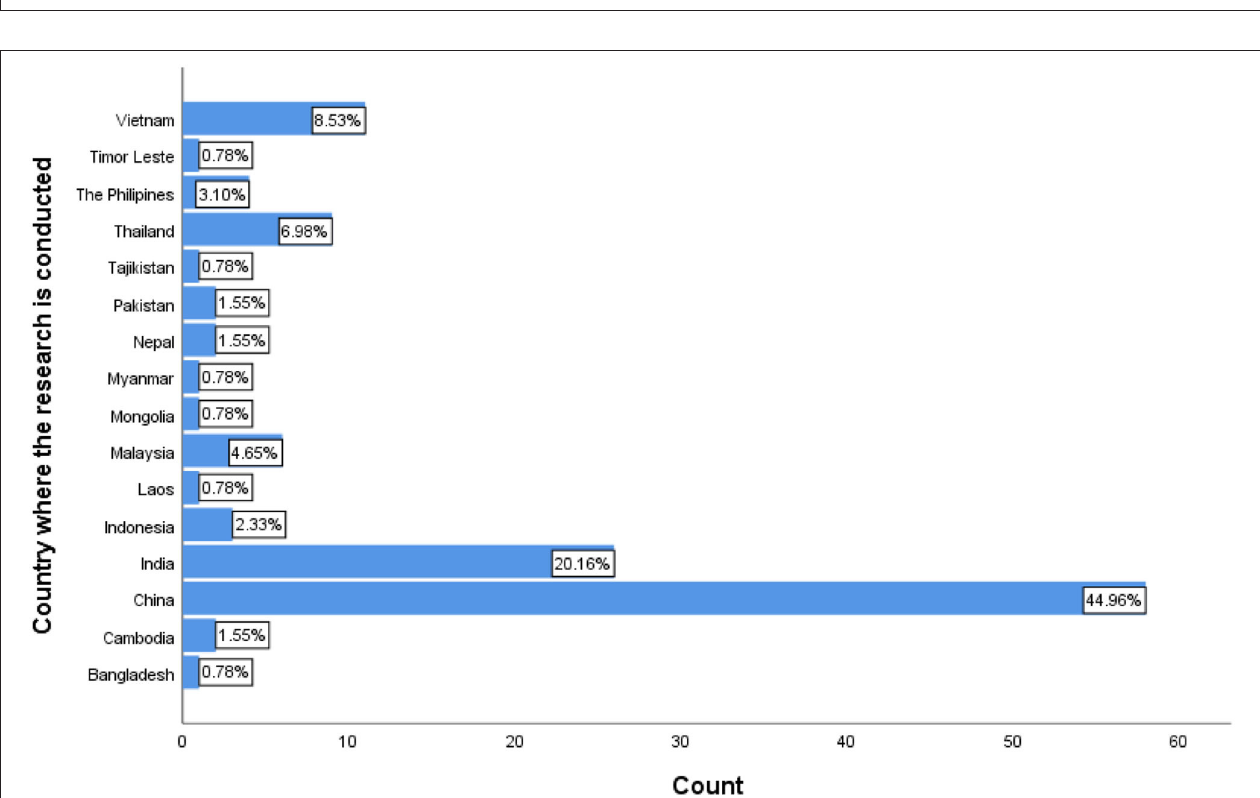
FIGURE 2 | Number of studies and year of